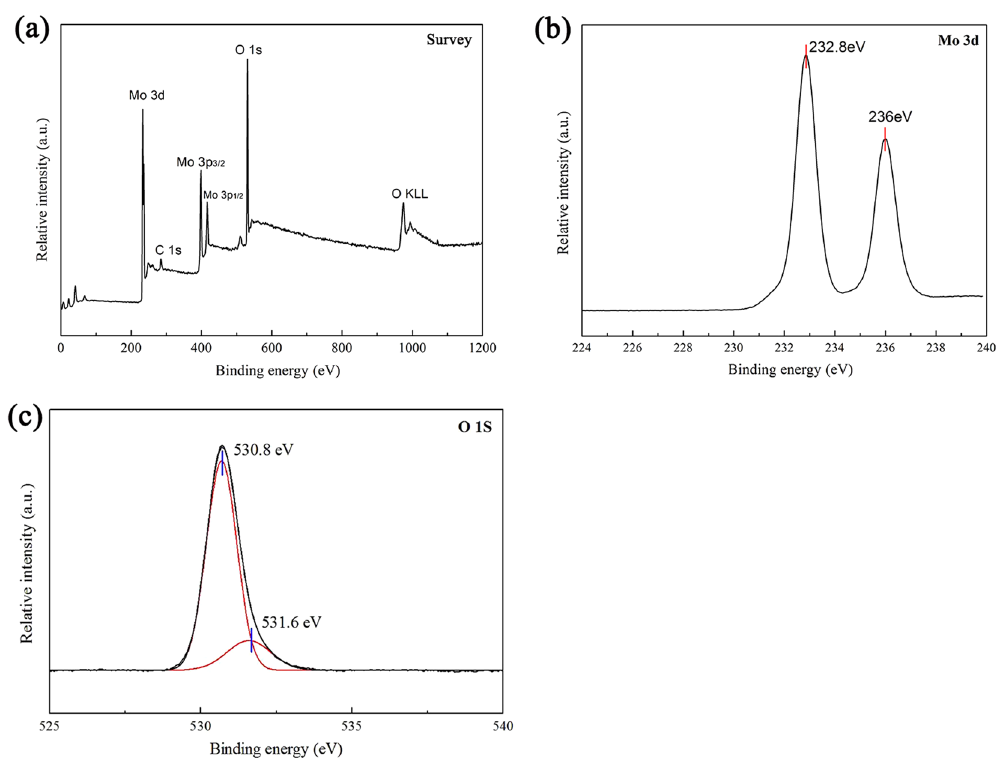
Figure 7. XPS spectra of the MoO 3 synthesized at 400 °C: ( a ) A typical survey spectrum. ( b ) Mo 3d core level. ( c ) O 1 s core